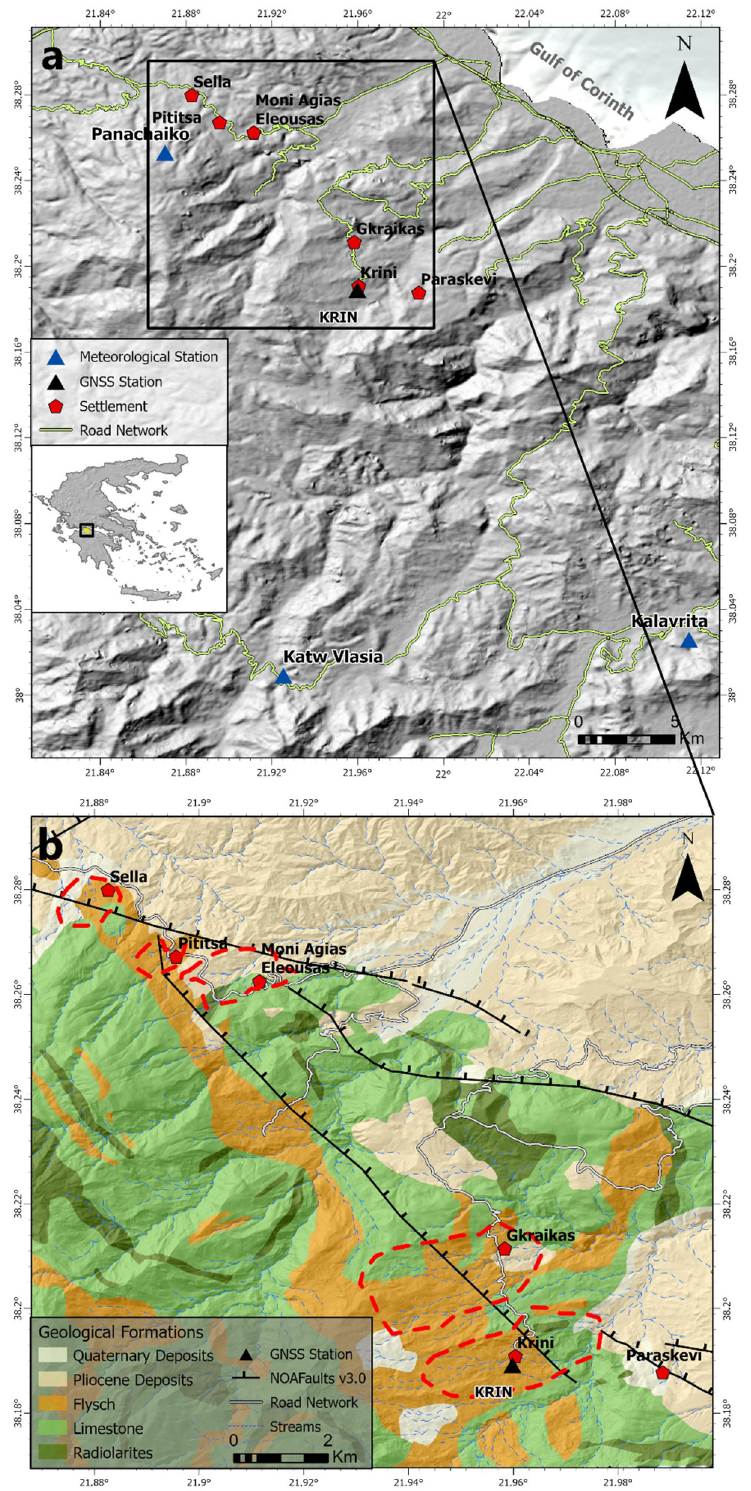
Figure 1. ( a ) shaded relief Map of northeastern Achaia showing the area of interest (box) including the villages where landslides have occurred; ( b ) simplified geological map [47,48]. The landslide of the village of Krini is located on flysch, and the Pititsa landslide is located on flysch and on Pliocene deposits. Active faults are shown with black lines, and red-dashed outlines represent the boundaries of the landslides (ticks on the downthrown side).